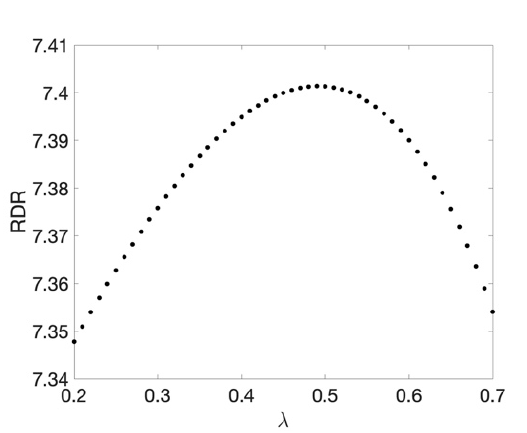
Figure 21. RDR vs. 𝜆 for an integrating time delay process. Figure 21. RDR vs. λ for an integrating time delay